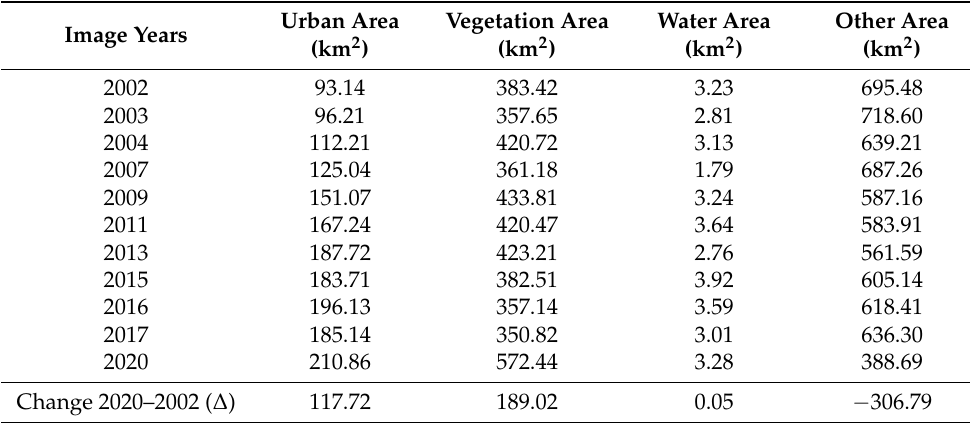
Table 4. The land cover areas and changes for the years 2002 to